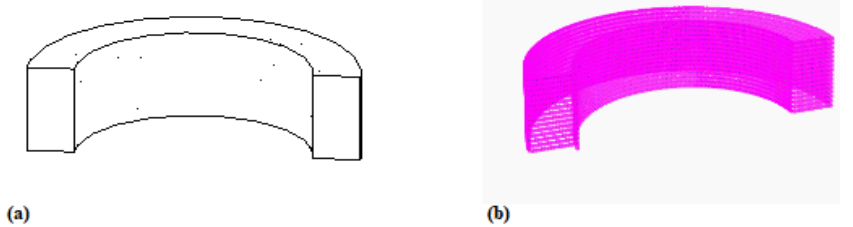
Figure 6. ( a ) Element created in Revit TM ; ( b ) element printing trajectory.